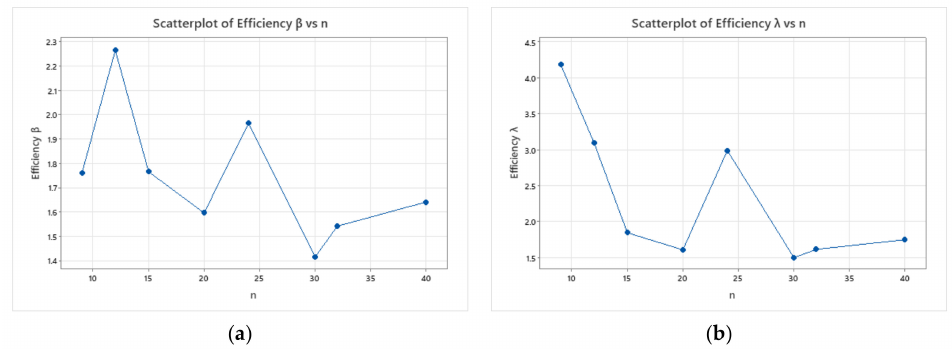
Figure 2. The efficiency of the MLE parameters β ( a ) and λ ( b ) when β = 1 and λ = 1.